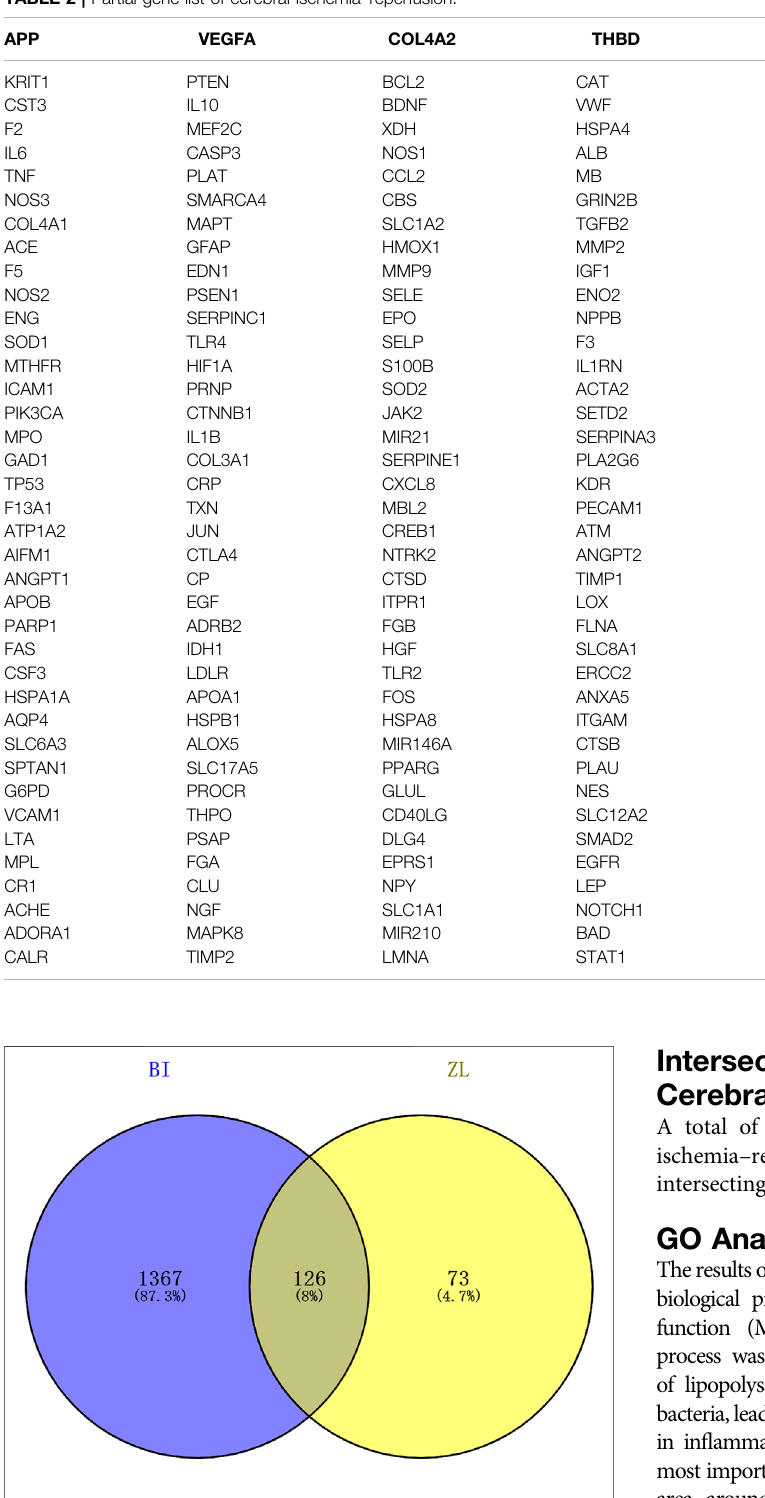
Frontiers in Pharmacology |